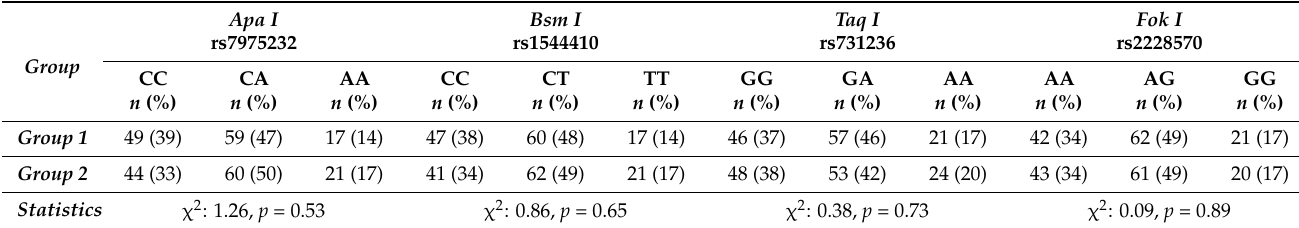
Table 4. Distribution of VDR gene genotypes among both